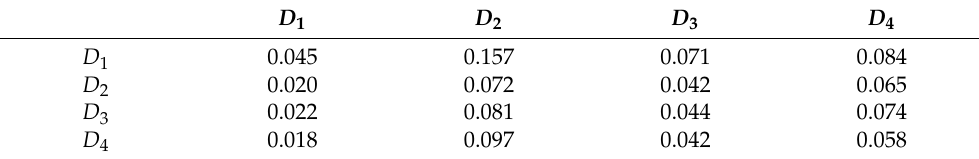
Table 6. Dimensional matrix T D .